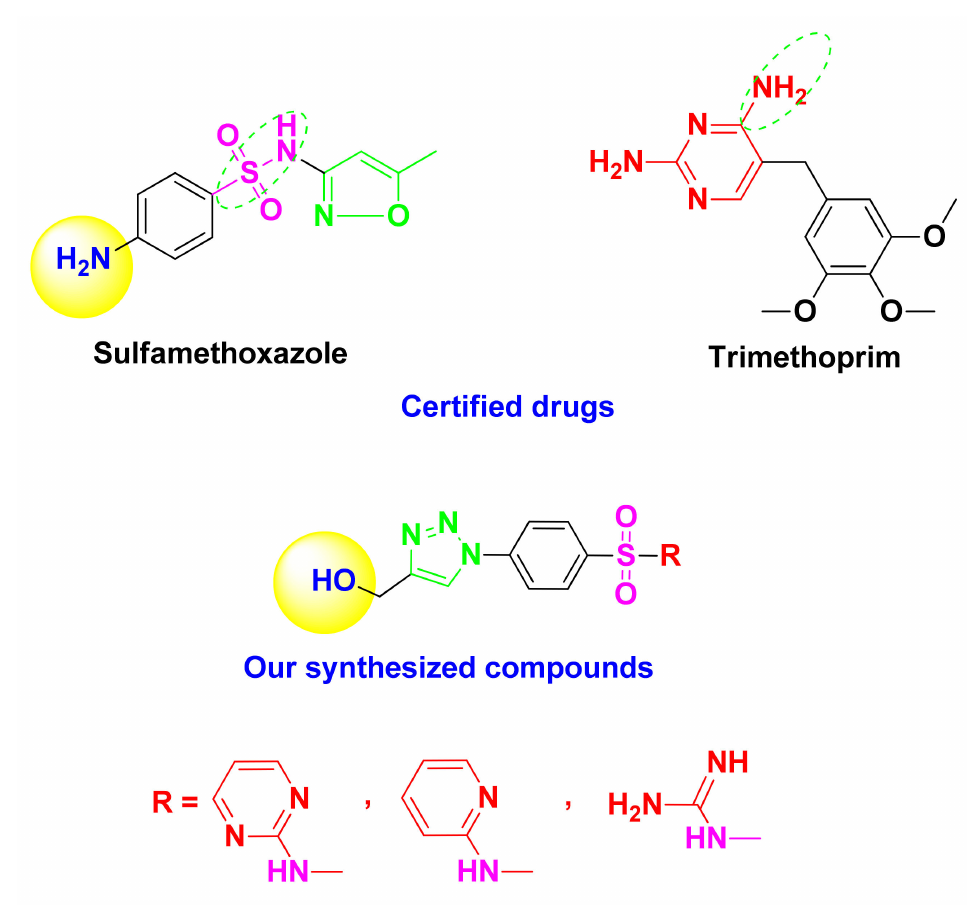
Figure 1. Certified drugs against bacterial